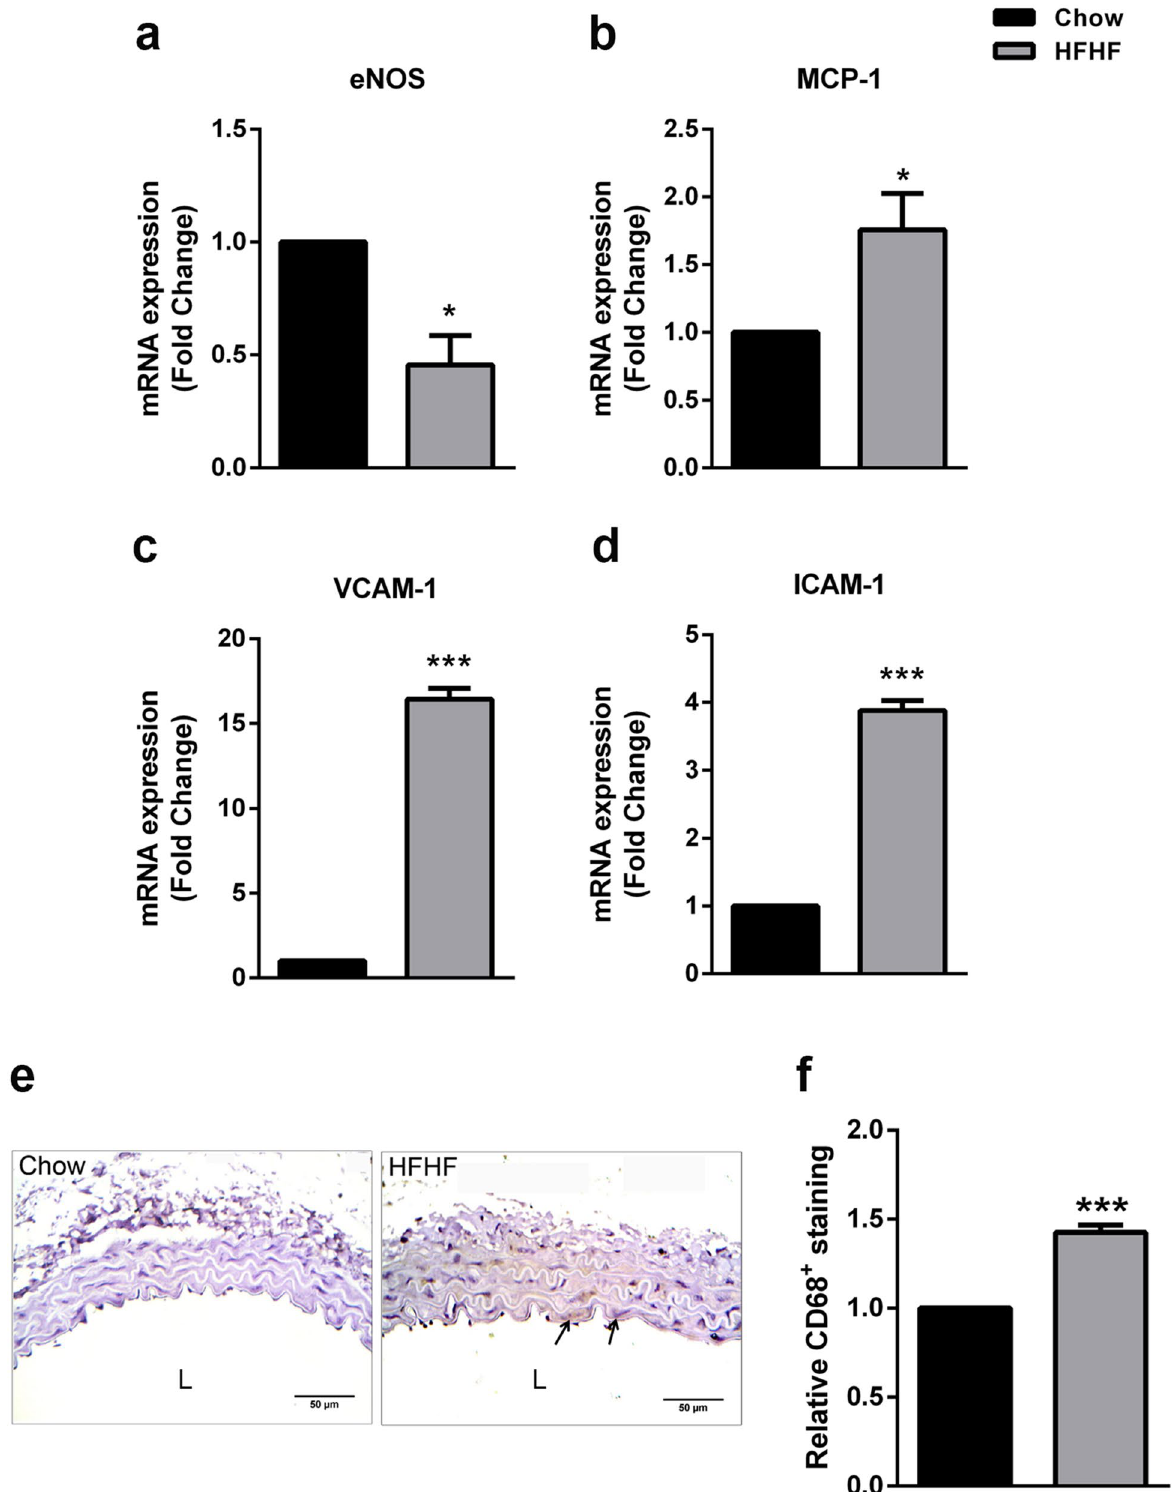
Figure 4. Endothelial dysfunction and activation in thoracic aorta of HFHF diet fed mice. Thoracic aorta from Control and HFHF groups were subjected to quantitative RT-PCR for ( a ) eNOS, ( b ) MCP-1, ( c ) VCAM-1 and ( d ) ICAM-1 (n = 3). ( e ) Sections were immunostained for CD68 (Scale bar = 50 µm; arrows indicate CD68 + staining). ( f ) Quantification of the positively stained areas was carried out using Image J (n = 5). Data were expressed as Mean ± SEM. *p < 0.05, **p < 0.01, ***p < 0.001 vs untreated control, unpaired two-tailed Student’s t-test. L